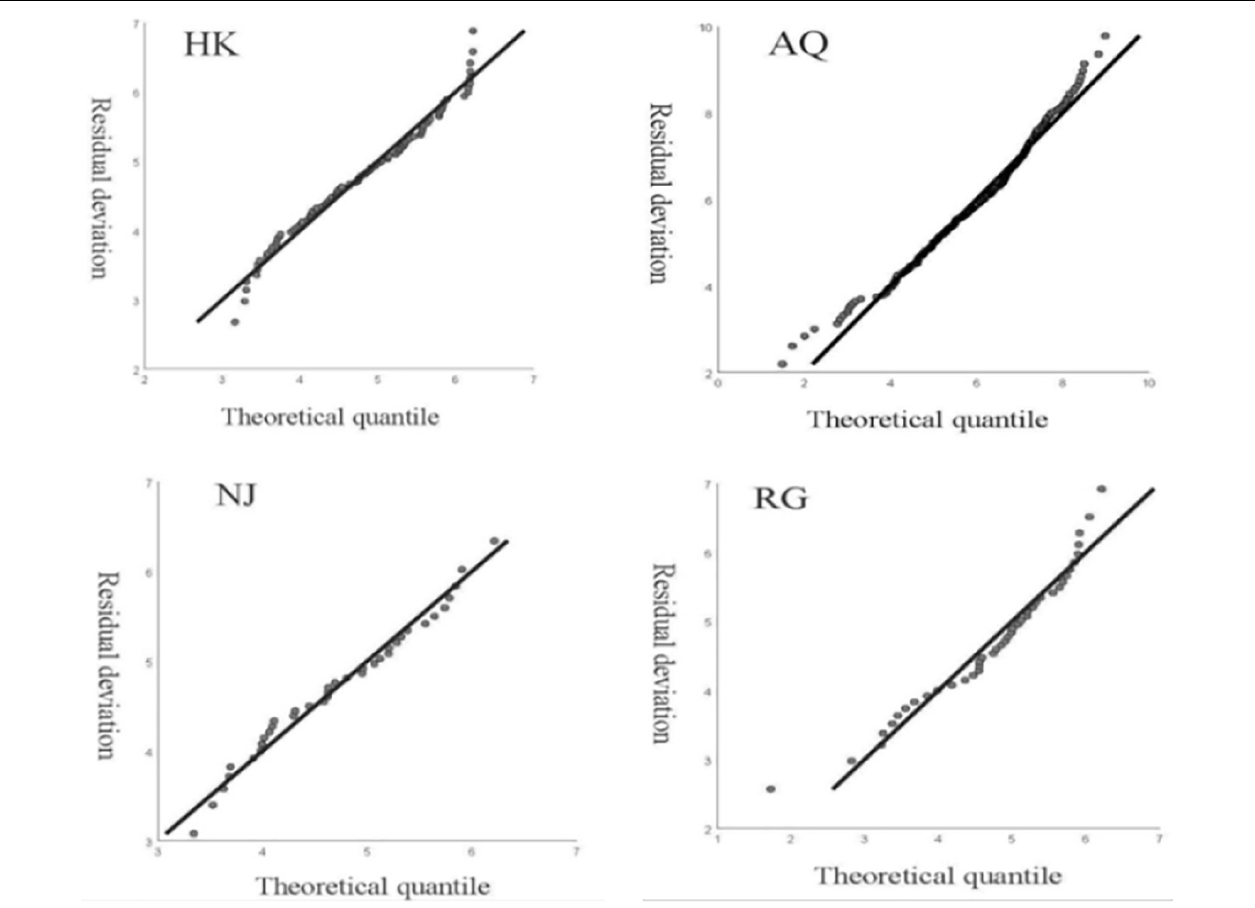
FIGURE 5 | Quantile–Quantile (Q-Q) plot validations for GAM model. The QQ diagram showed the straight line (y = x) approximately. The slope of this straight line is the standard deviation; the QQ diagram can make the normality of the visual inspection.